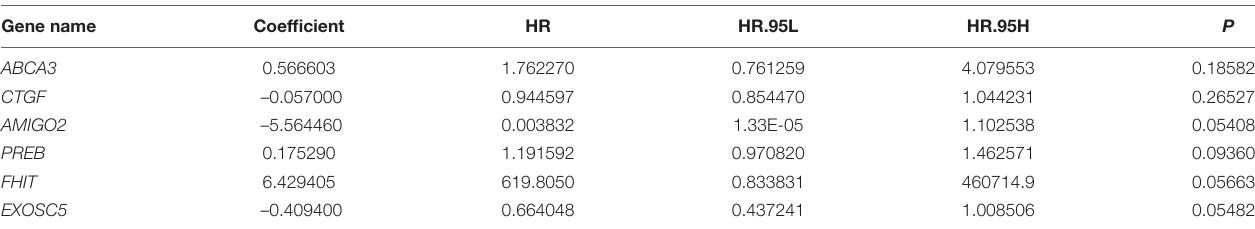
FIGURE 3 | Construction of a six-MRG prognostic model in the training cohort. (A,B) Lasso regression and stepwise multivariate Cox regression were used to construct the six-MRG signature. (C) The risk score distribution of patients in the training cohort. (D) The survival status of patients in the training cohort. (E) mRNA expression profiles of the six MRGs in the training cohort. (F) Kaplan-Meier survival analysis of patients in the training cohort. (G) ROC curve analysis of the six-MRG signature in the training cohort. TABLE 2 | Details of the six MRGs in the prognostic